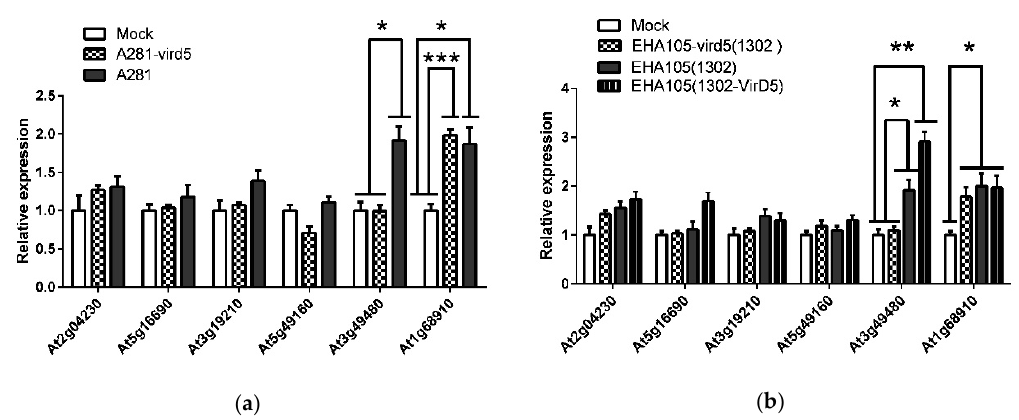
Figure 1. The expression of the genes possibly directly regulated by VirD5. ( a ) The expression in Arabidopsis leaves syringe (needleless) infiltrated with Agrobacterium A281 or its virD5 deletion mutant A281– vird5 . ( b ) The expression in Arabidopsis leaves syringe (needleless) infiltrated with A. tumefaciens EHA105 and its virD5 deletion mutant EHA105- vird5 , either carrying a binary vector pCAMBIA1302 or pCAMBIA1302:VirD5. Leaf samples from the infiltrated area were collected at 48 h after inoculation, and total RNA was isolated for QRT-PCR. RNA from the Mock (10 mm MgCl 2 solution) infiltrated Arabidopsis leaves collected at 48 hpi was used as a calibrator to determine the relative number of gene transcripts. All data are the means ± SE from three biological replicates. The data were made into graphs using GraphPad PRISM 5 software (La Jolla, CA, USA). *, p < 0.1; **, p < 0.01; ***, p < 0.001.